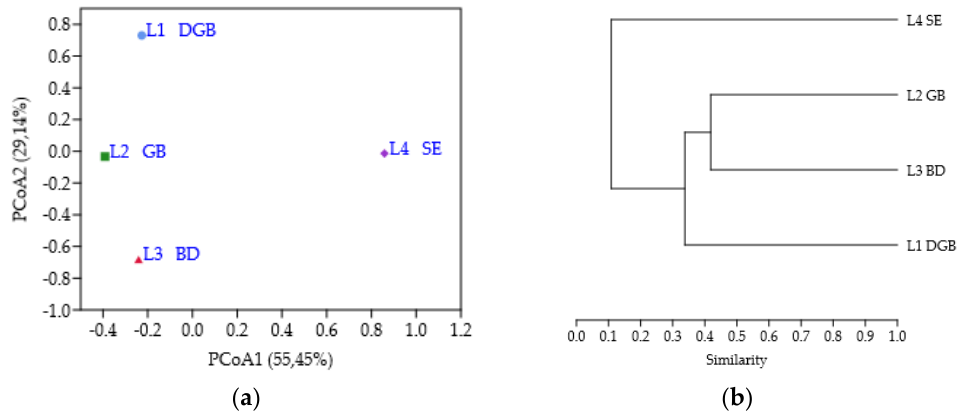
Figure 7. Depicting patterns of beta diversity for fungal communities in the different samples. ( a ) Principal coordinates analysis (PCoA) plot based on fungal genera composition. ( b ) UPGMA clustering analysis.